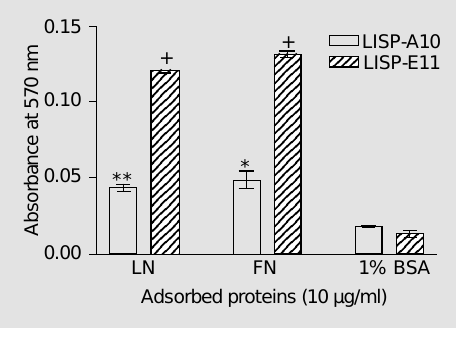
Figure 6. Anchorage-independ- ent growth of LISP-A10 (A) and LISP-E11 (B). Known numbers of log-phase cells in single-cell suspensions were plated onto 0.6% agarose. Colonies were grown for 14 days and spheroid formation was noticed after 7 days, only for LISP-A10. Bars: 50 µm.